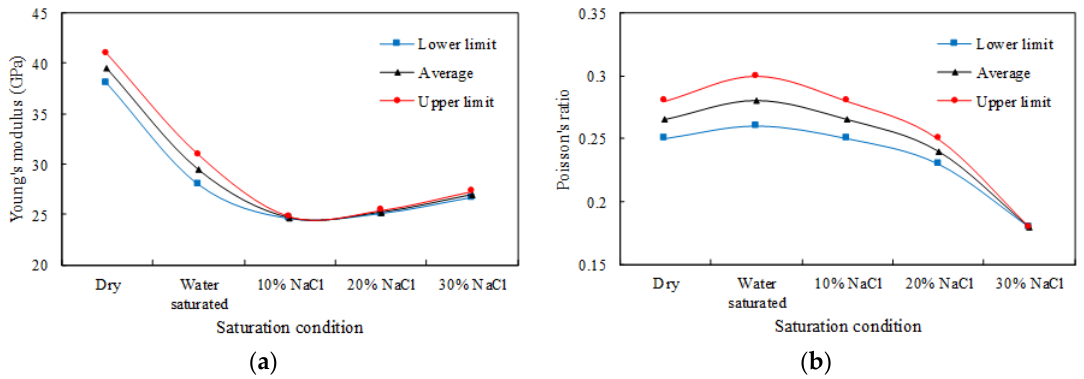
Figure 4. Variation of siltstones’ ( a ) Young’s modulus and ( b ) Poisson’s ratio with pore fluid saturation. Note that water saturation causes a reduction of Young’s modulus and increment of Poisson’s ratio. But saturation of brine with high concretions causes both trends to be reversed.